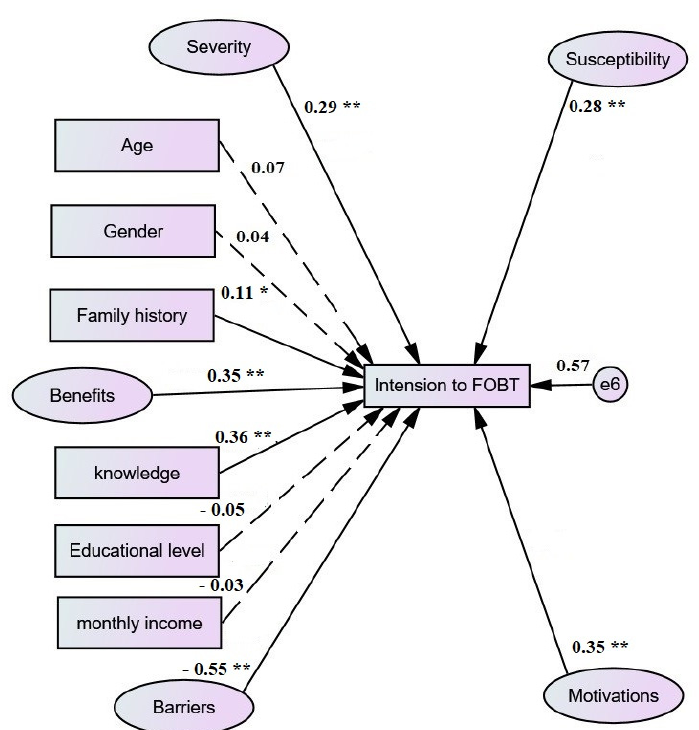
Figure 1. The preliminarily model predicts screening practice intention; dotted lines mean insignifi- cant paths. * p < 0.05, ** p < 0.001. All regression estimates are standardized β coefficients.